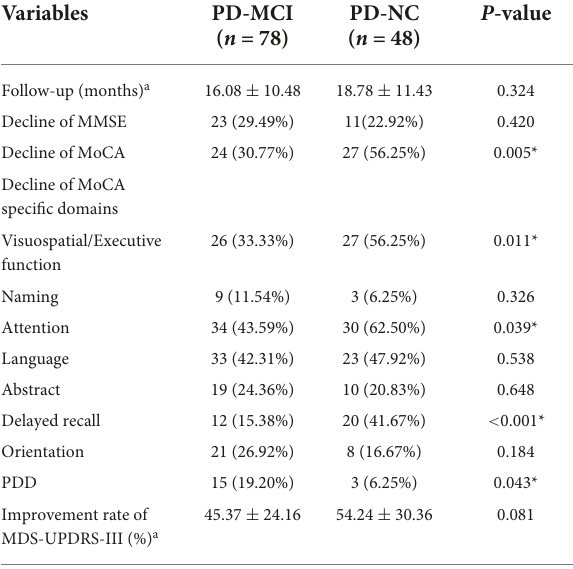
TABLE 2 Percentages of cognitive decline and rates of improved MDS-UPDRS-III outcomes at the last follow-up between the PD-MCI and PD-NC